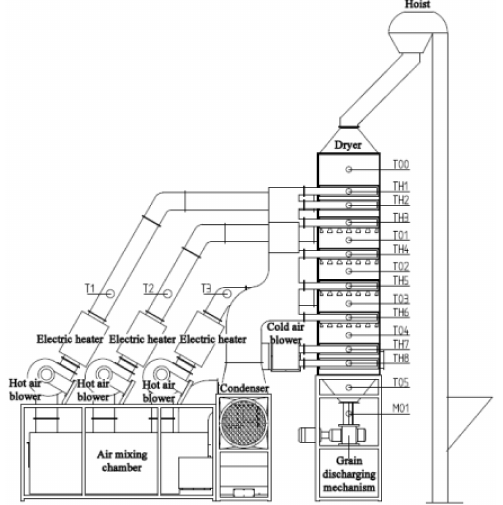
Figure 4. Drying test system structure and sensor